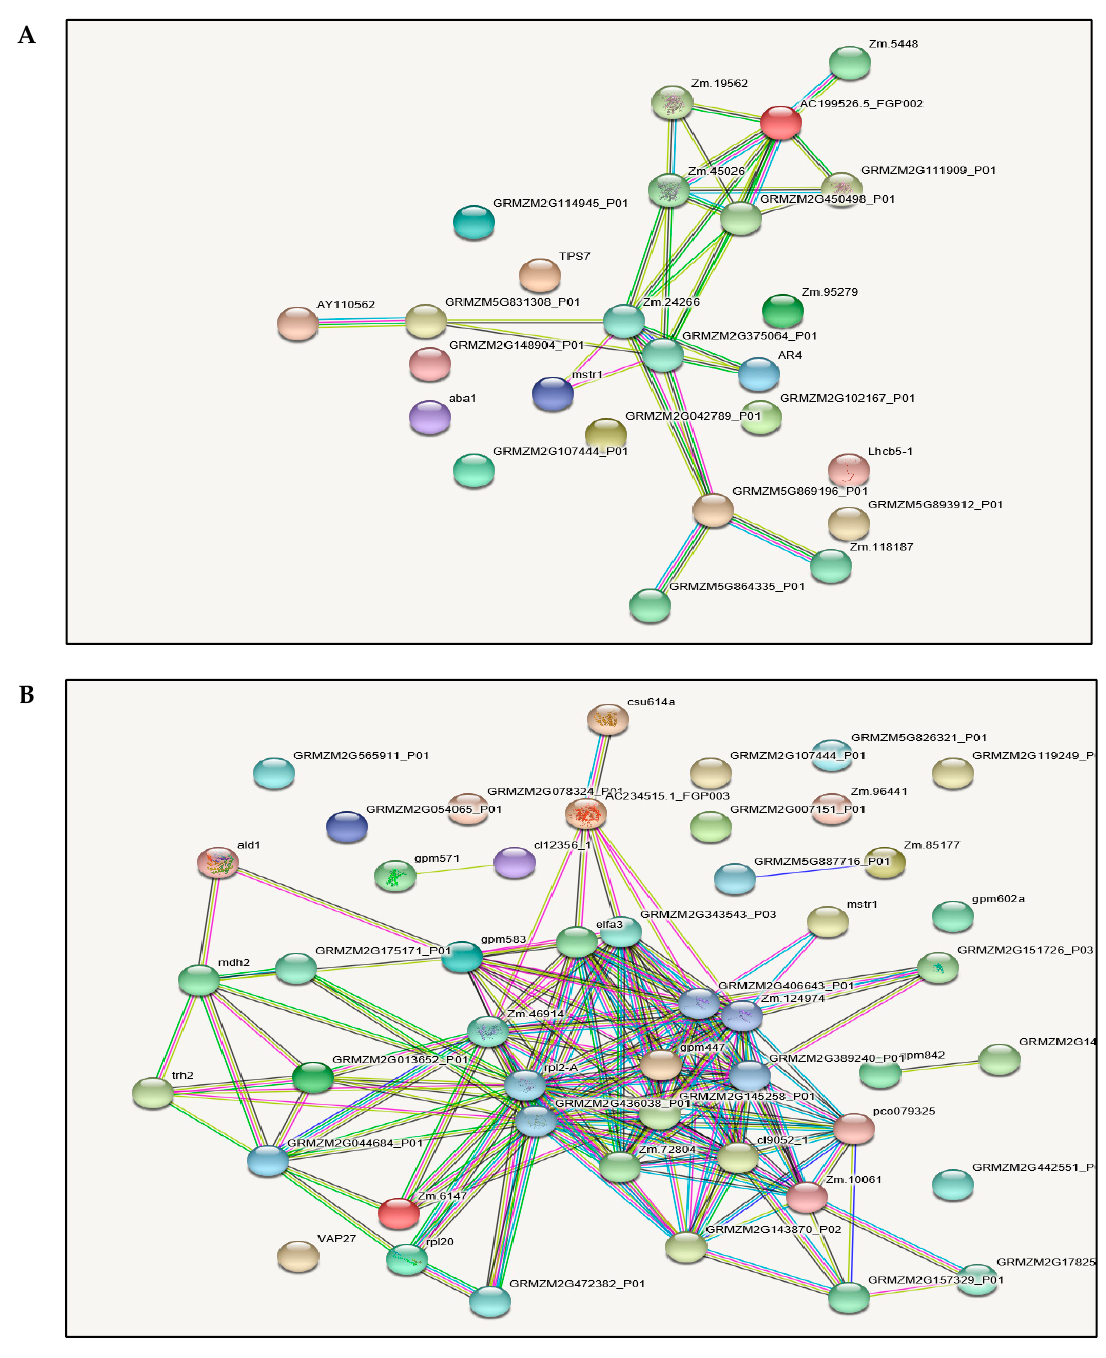
Figure 7. Protein interaction network consisting of DAPs identified in drought stressed maize seedling leaves of ( A ) YE8112 ( B ) MO17. The network was constructed using the String program (http:// www.string-db.org/) with a confidence score higher than 0.5. Nodes represent proteins, and the line thickness represents the strength of the supporting data .